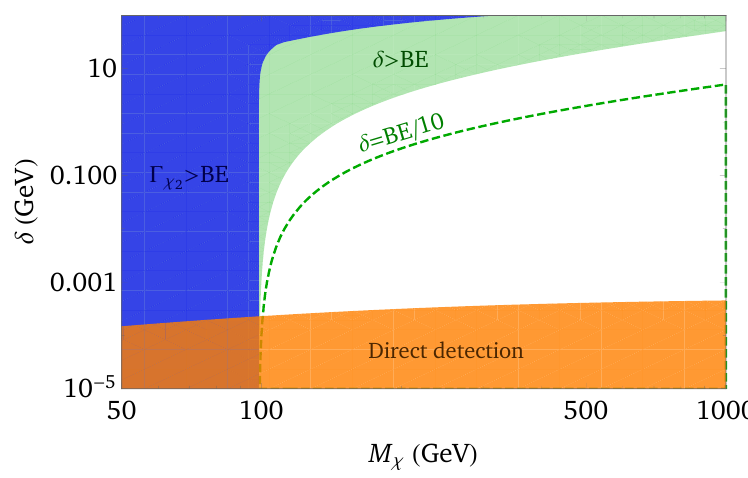
Figure 7 . The white region corresponds the parameter space where our discussions on bound state collider physics (see section 3.2) remain valid in the presence of a nonzero (cid:14) , and where the dark matter candidate (cid:31) 1 satis(cid:12)es the direct detection constraints (see section 4.1). M Z 0 = 30 GeV